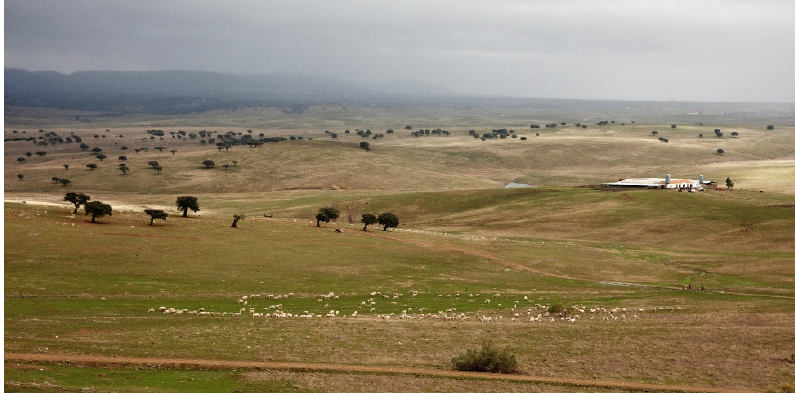
Figure 3. Agricultural landscape in the Valle de Alcudia. Source: M. A. Serrano de la